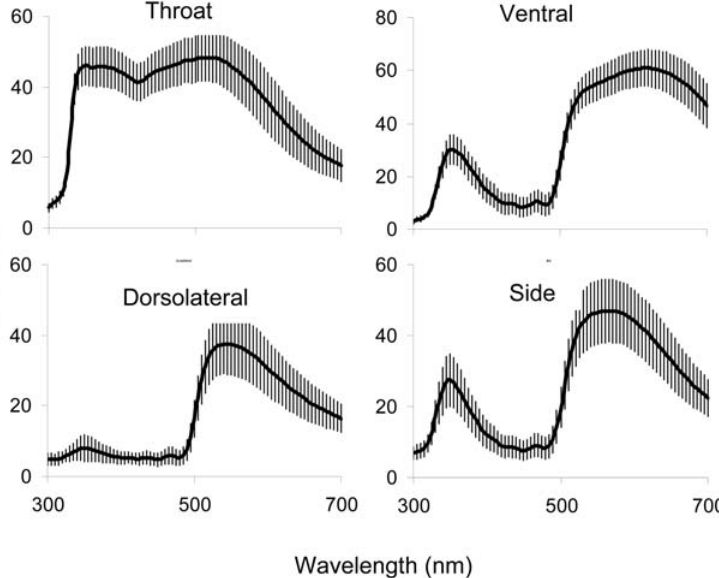
Figure 2. Mean reflectance spectra for each male body region (N=116). Bars are the standard deviation around the mean. Note the substantial UV reflectance (300–400 nm) of the throat, side and ventral region.